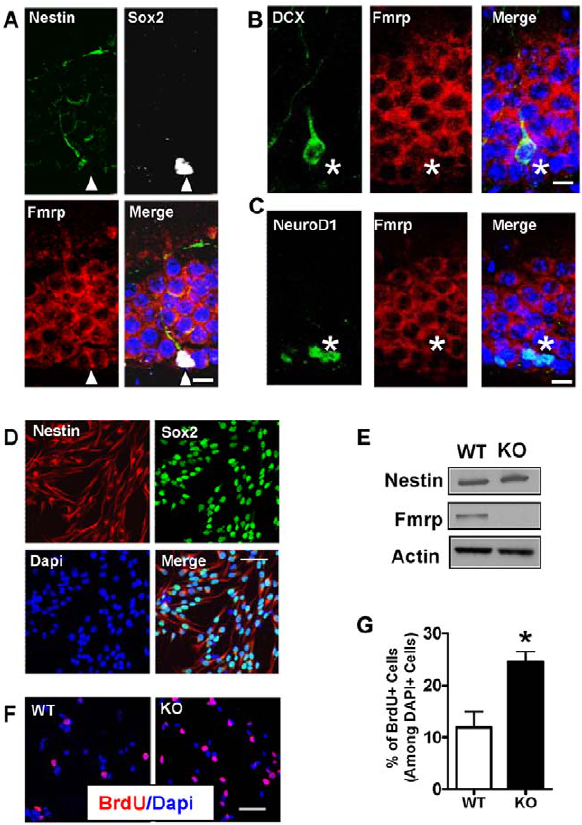
Figure 1. Fmrp is expressed in aNPCs and new neurons in the adult DG, and the loss of Fmrp leads to increased aNPC proliferation. (A) Fmrp is expressed in Sox2 (white) and Nestin (green) double-positive NPCs (arrowheads) in the granule neurons of the adult hippocampus. Arrowhead points to a positive cell located at the subgranular zone adjacent to the hilar region. (B,C) Fmrp is expressed in doublecortin (DCX)-positive (B, green) and NeuroD1-postive (C, green) newly generated neurons. Asterisks identify positive cells located at the subgranular zone adjacent to the hilar region. (A–C, Fmrp, red; Dapi, blue; Scale bars=10 m m;). (D) aNPCs cultured under proliferating conditions expressed the neural progenitor markers Nestin (cytoplasmic, red) and Sox2 (nuclear, green; Dapi in blue). (E) Proliferating WT aNPCs, but not Fmr1 KO aNPCs, expressed Fmrp. (F) Both WT and KO aNPCs incorporate the thymidine analog, BrdU, under proliferating conditions (BrdU, red; Dapi, blue; (D,F), Scale bars=50 m m). (G) Quantitative analysis showing that a higher percentage of Fmr1 KO aNPCs incorporated BrdU. (*, p , 0.05; n=3; Student’s t-test; mean 6 SEM).